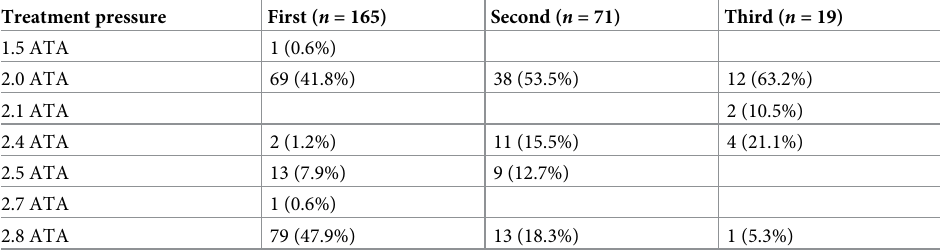
Table 2. Treatment pressure in each HBO 2 session during the first 24 h.